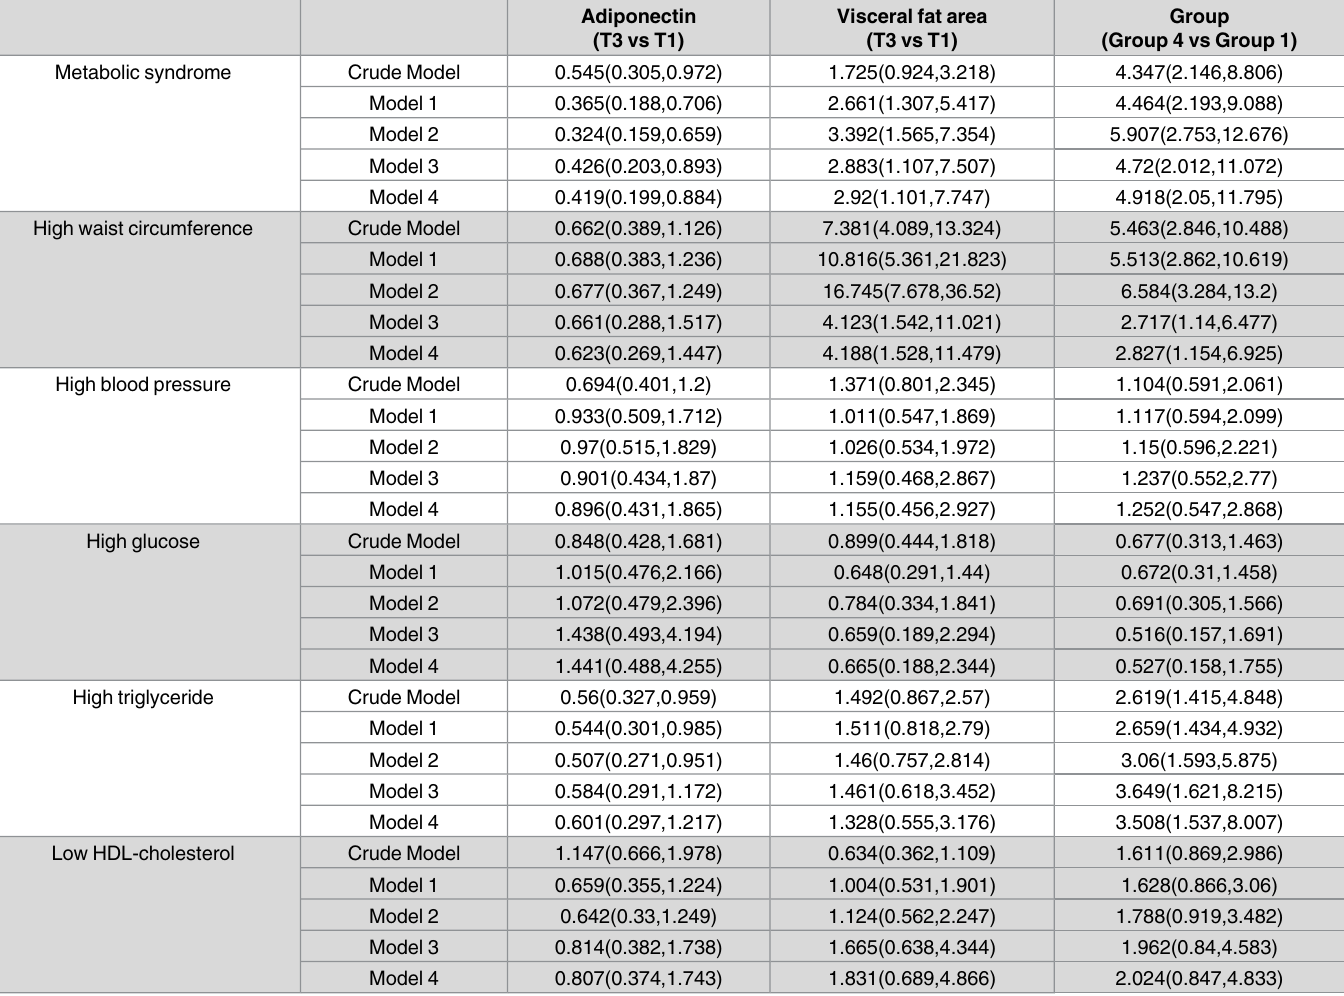
Table 3. Associations among adiponectin, visceralfat area and their groups for metabolic syndrome and its risk factors.